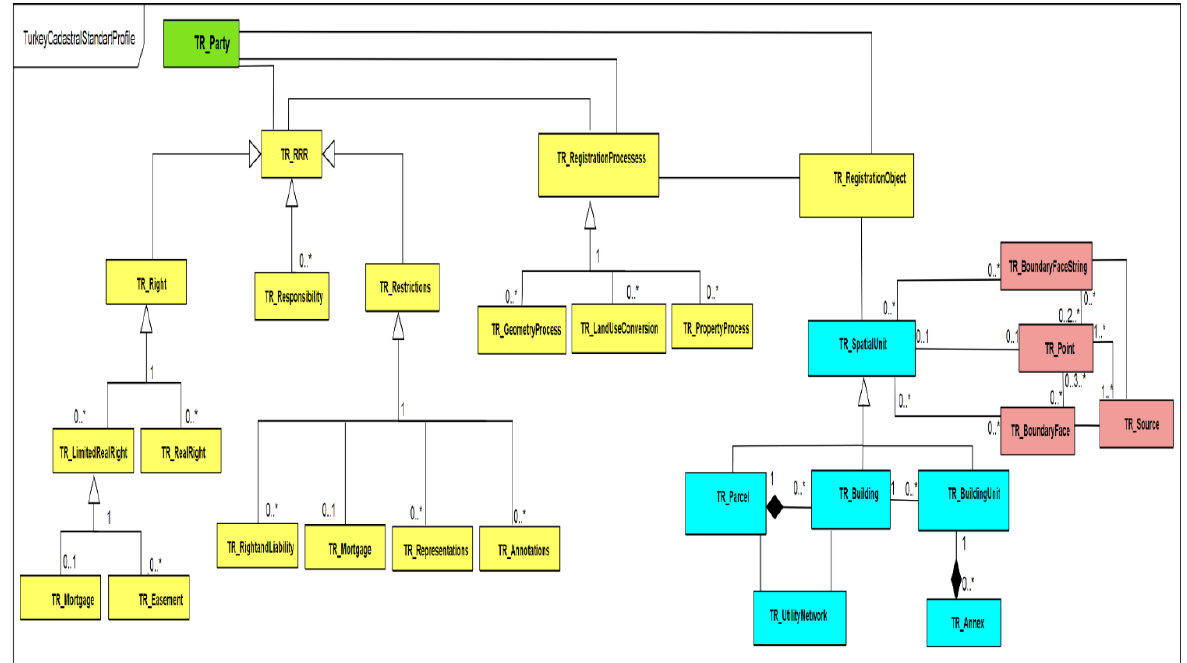
Figure 3. Proposed implemetnation of LADM classes for the Turkish cadastral conceptual model facilities. In the existing cadastral system in Turkey, utility